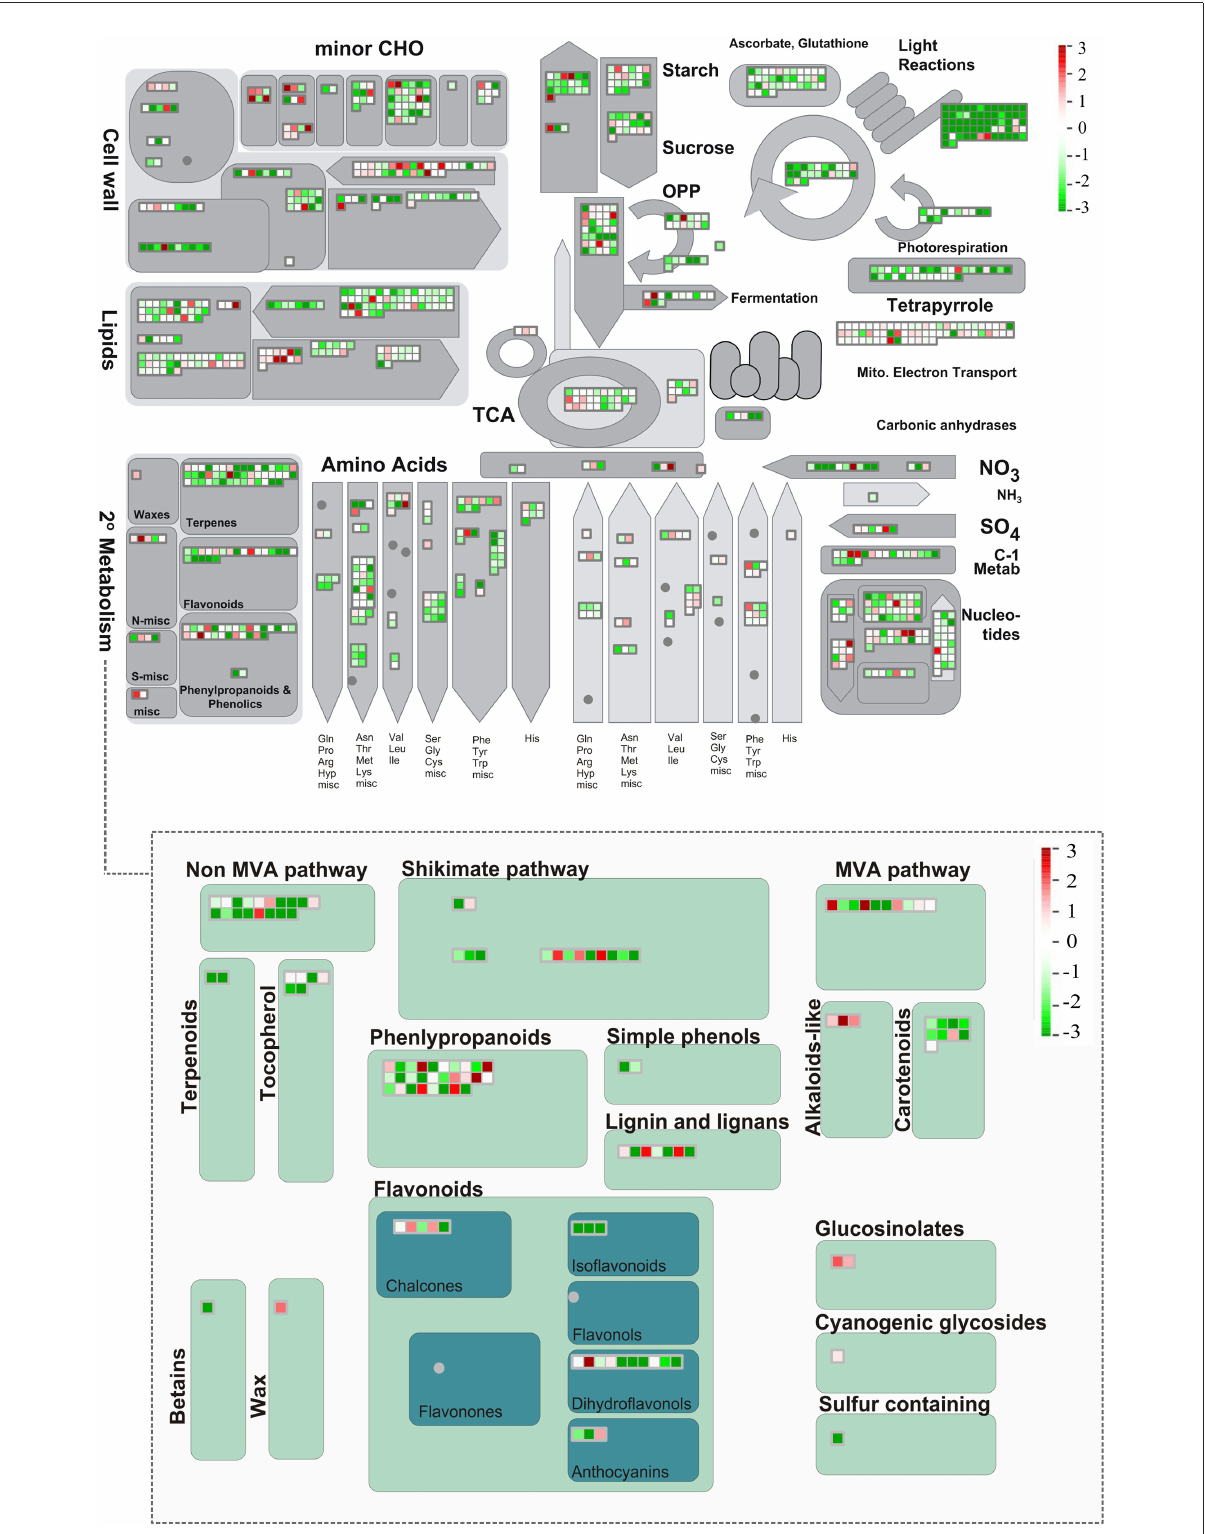
FIGURE6 Overview of metabolic pathways of expressed transcripts performed in MapMan. Each small square represents an expressed transcript in leaves or seeds, exclusively or shared, with red color corresponding to up-regulated genes, green down-regulated transcripts, and blue unchanged transcripts. The color scale shows the fold change value in